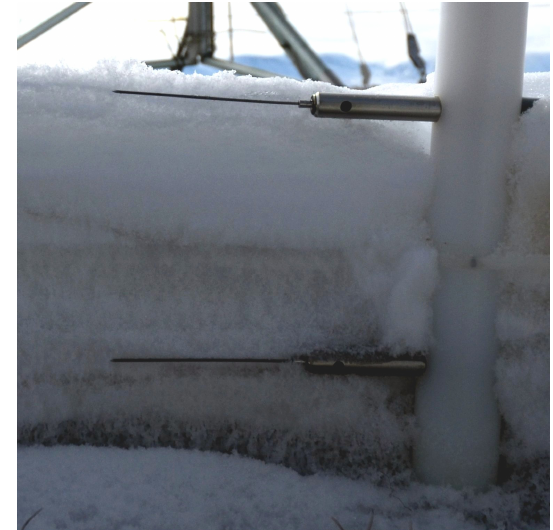
Figure 9. Photograph of the snow stratigraphy taken on 14 May 2014. The NPs are 7 and 17cm above the ground. The various depth hoar and indurated depth hoar layers between 0 and about 11cm are clearly visible, as well as the wind slab between 11 and 16cm.